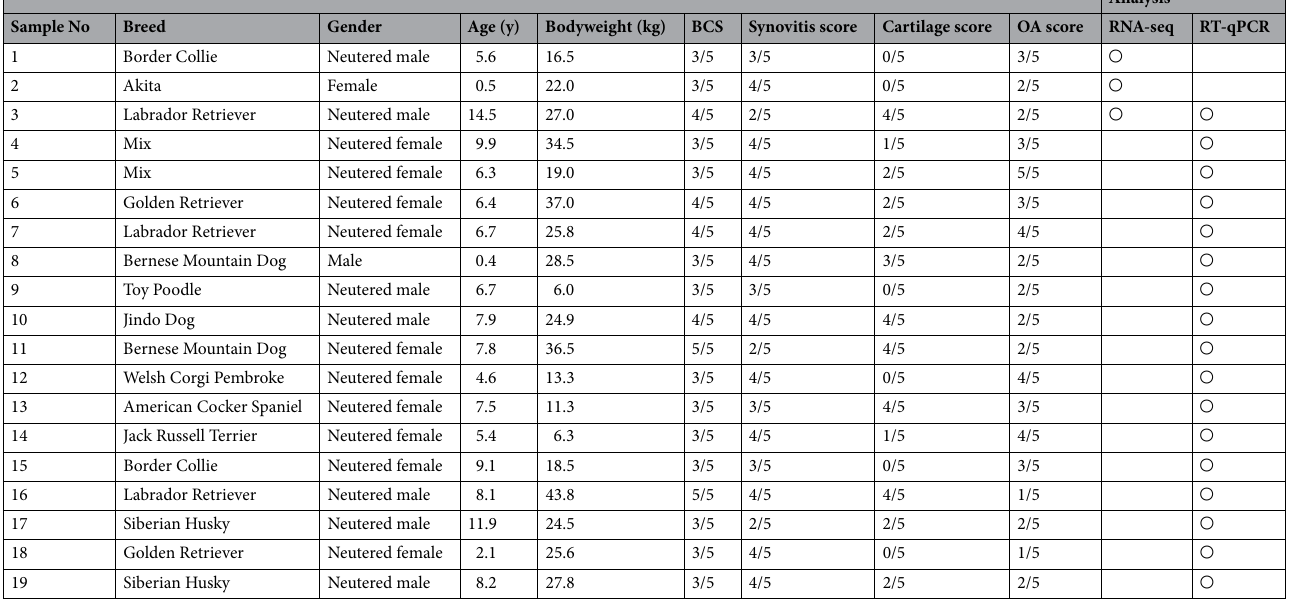
Table 1. Clinical information in the OA